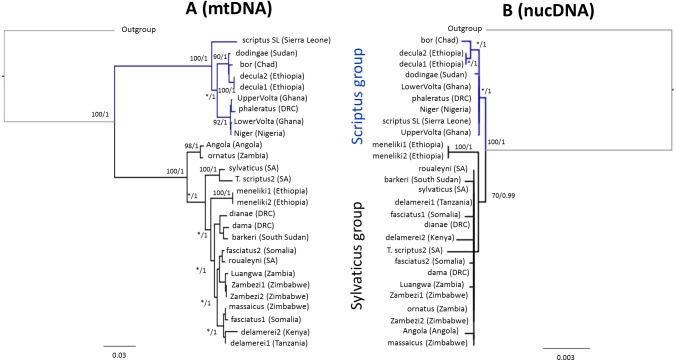
Tree topologies based on maximum likelihood retrieved from (A) the combined mtDNA data and (B) the combined nucDNA data.Values given above the branches represent maximum likelihood bootstrap values and maximum clade probabilities.